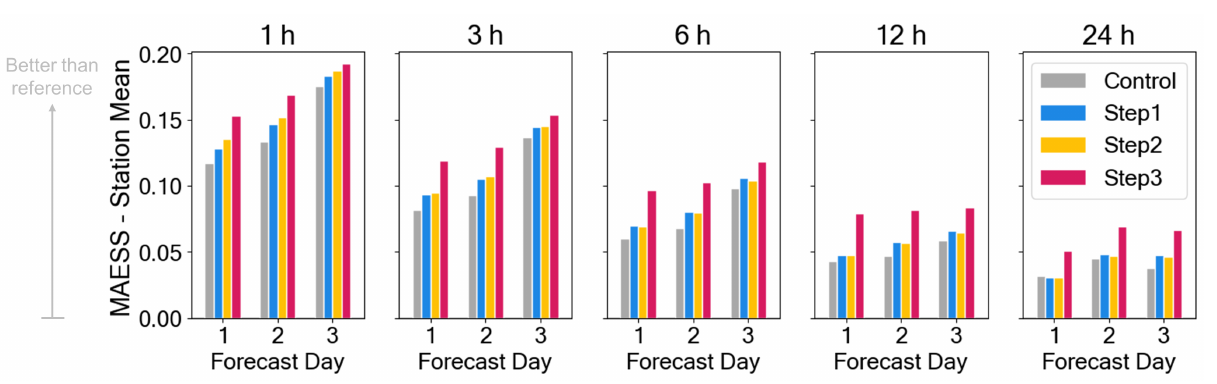
Figure 8. Station mean of the mean absolute error skill score (MAESS) by forecast day and for hourly to daily rolling windows, relative to the raw NWP